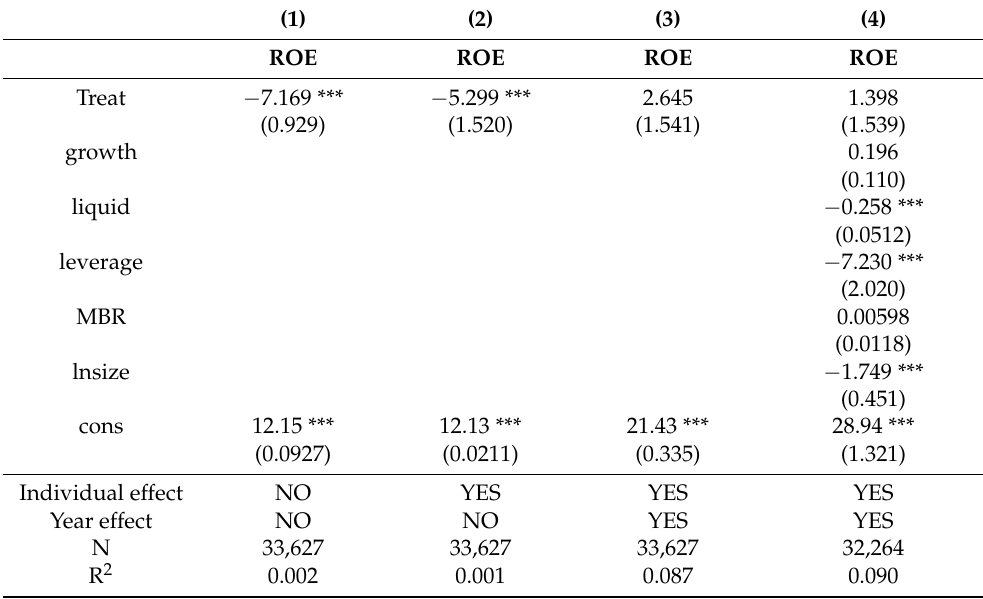
Table 4. Placebo